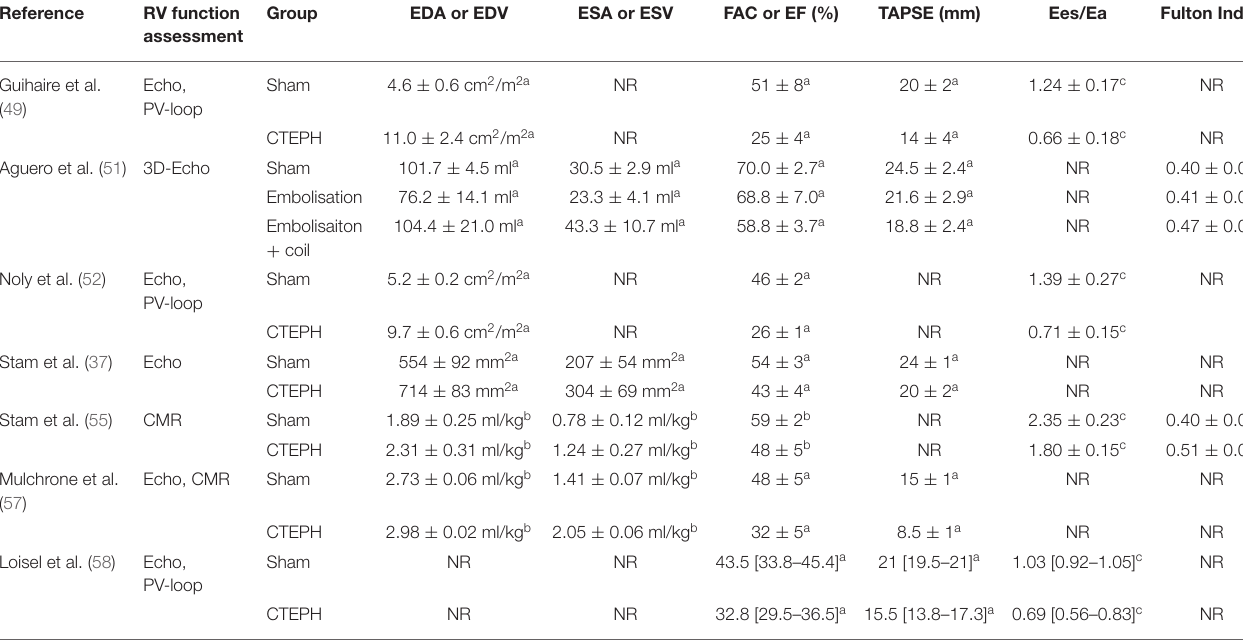
TABLE 2 | Overview of RV-functional measurements in CTEPH/CTED models.